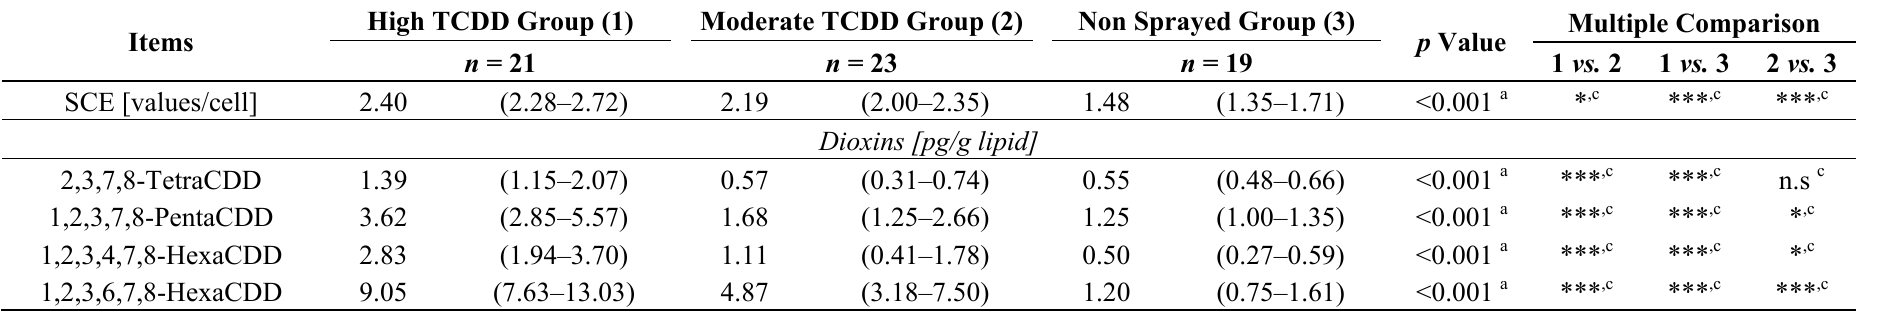
Table 2. Comparison of SCE (sister chromatid exchange), dioxin congeners and total concentrations in breast milk between high and moderate TCDD groups and non sprayed